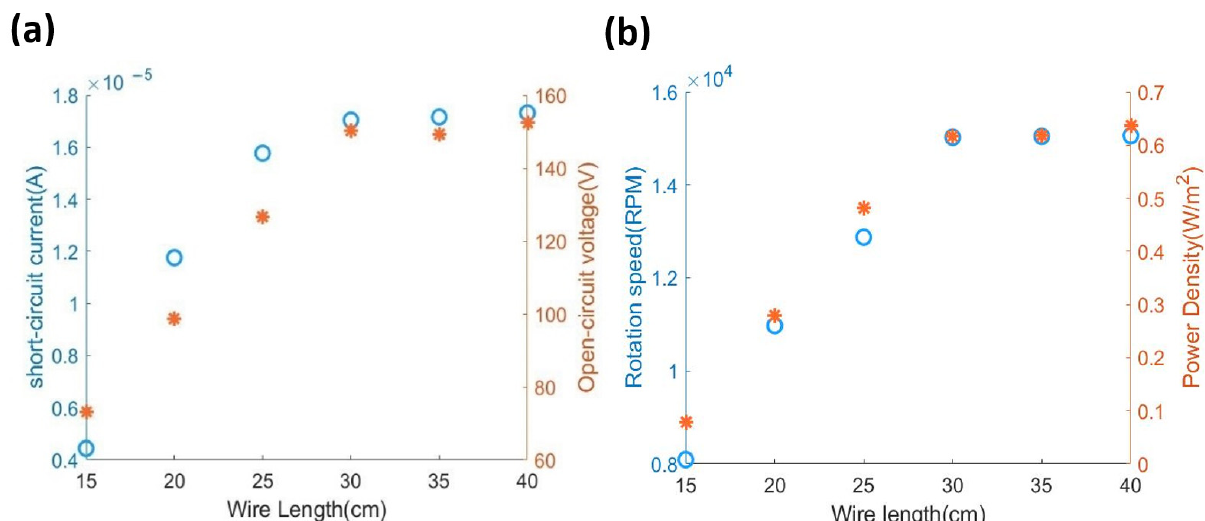
Figure 5. The result of HDR-TENG using different length cables. ( a ) Optimization of the wire length of the device. The blue circles represent the short-circuit current, and the open-circuit voltage is represented by the red stars. The load resistance for the test is 10 M Ω . ( b ) Rotational speed and power density at different wire lengths.